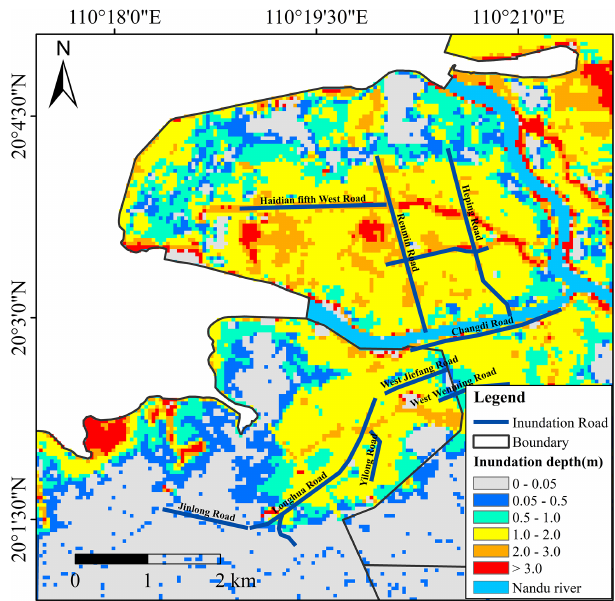
Figure 4. Spatial extent of simulated and measured inundation area and depth during TC1415.